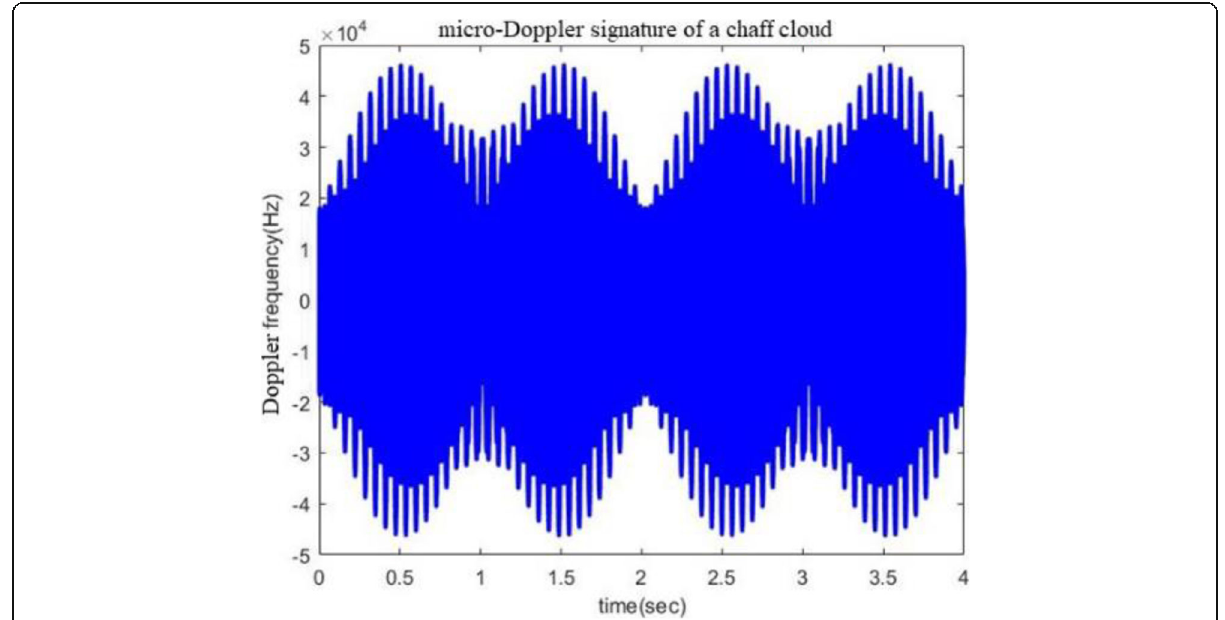
Fig. 8 Time-frequency spectrum of the micro-Doppler frequency of a chaff